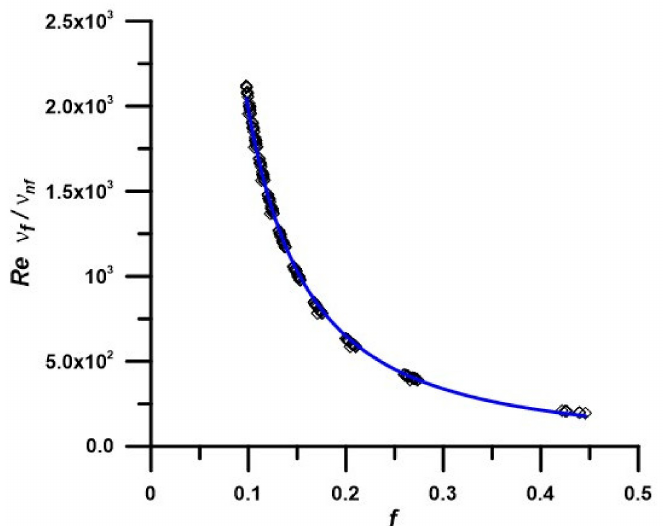
Figure 10. Average friction factor at different nanofluid properties depending on temperature and nanoparticle